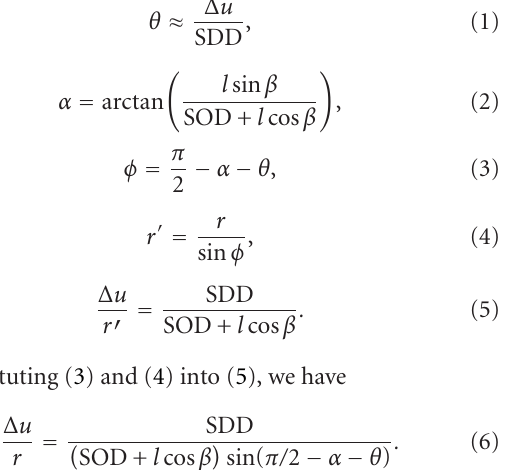
Figure 2: Projection and backprojection of a point with a small detector horizontal o ff set.